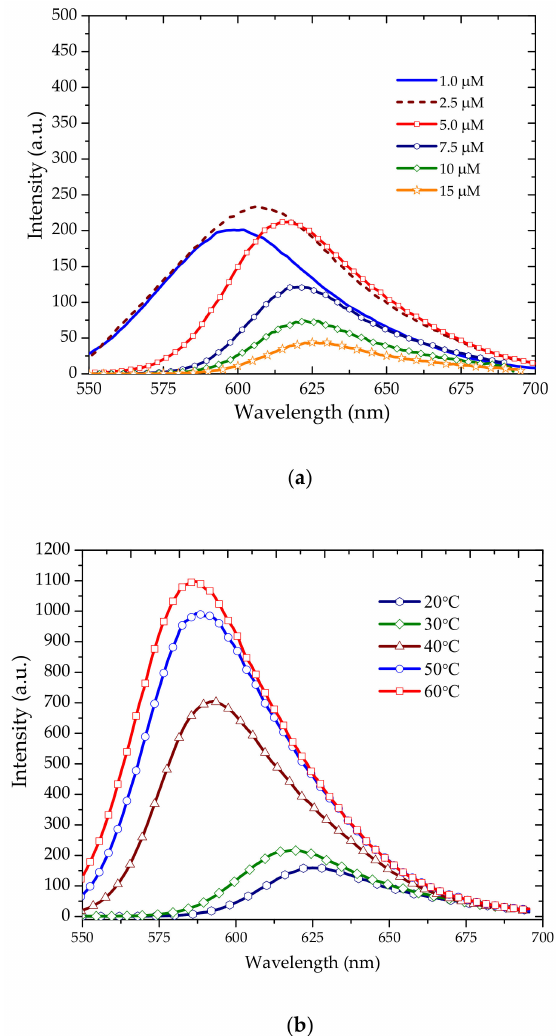
Figure 3. ( a ) Fluorescence spectra of TCP in benzene in different concentrations at 20 ◦ C; ( b ) Fluorescence spectra of 15 µ M TCP in benzene at different